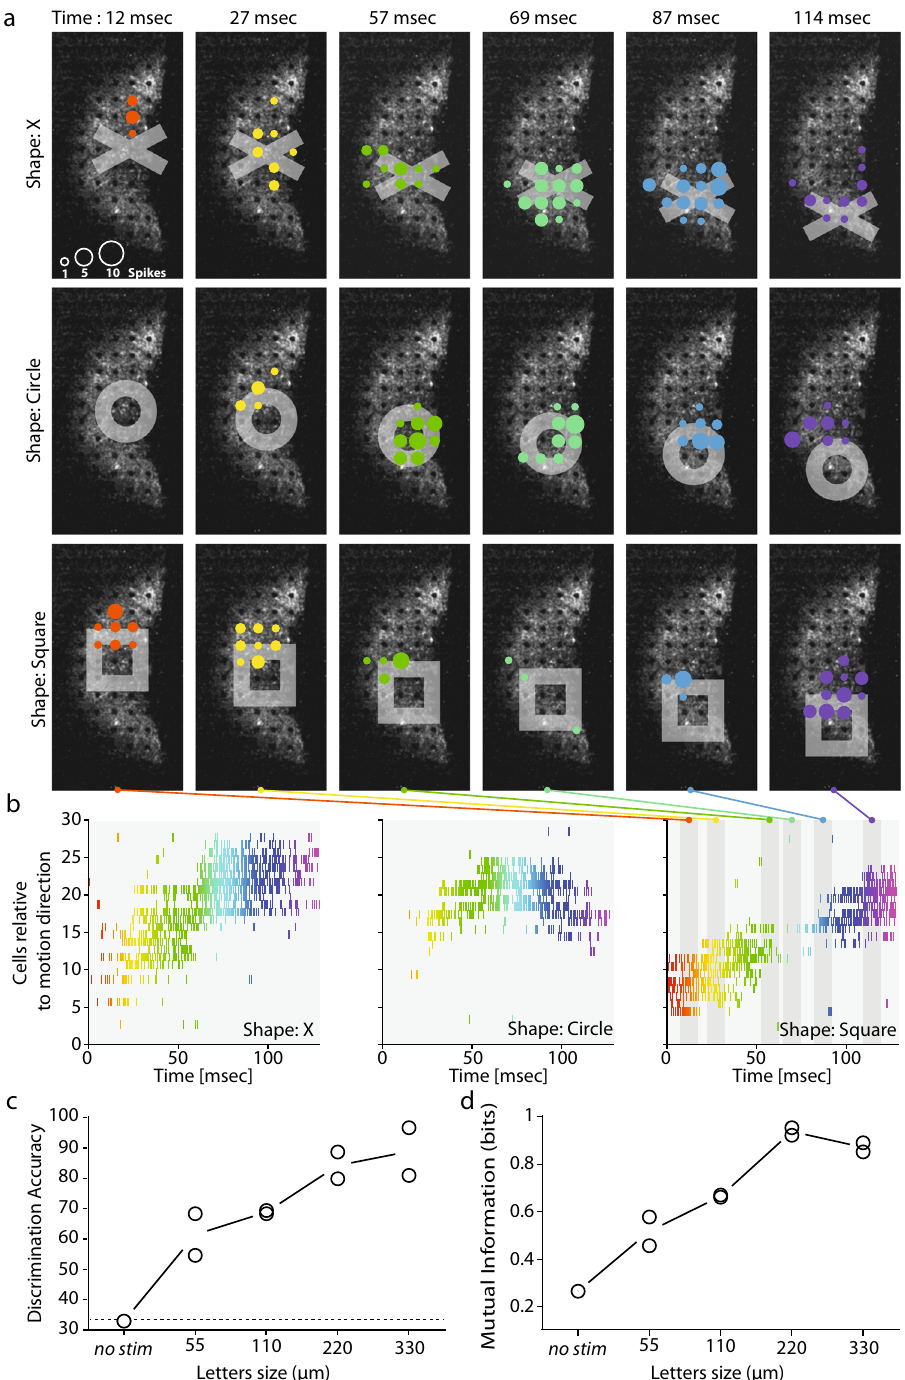
Fig. 7 The measured activity can be used to discriminate stimulation with different shapes and to predict visual acuity. a Responses of cells to three different shapes (rows: X, circle and square, columns: six different times) moving from the center towards the bottom of the retina. The colored disks indicate the electrodes where cells are recorded spiking. The size of the disks show the number of spikes detected in a 10-ms time window centered on the time indicated at the fi gure top. Color of the disks changes with timing in the sequence. b Raster plots showing the activity of the cells over time. The three shapes (X: left, circle: center and square: right) triggered different patterns of activity in the cell population. Color of the action potential on the raster change with time, fi tting the color code in a . The six different time windows used in a are shown as the gray area over the right panel (square). c Discriminability (as a %) of the features of the spatiotemporal spike response obtained from population spike trains for different sizes. Discriminability increased with letter size. “ No-stim ” discrimination was performed with the spontaneous activity pattern just before the start of stimulation. The no-stim discrimination rate was about 33%, as would be expected by chance alone for three shapes. d Normalized mutual information from the confusion matrix obtained from the discrimination rates in ( c ). The information tends to increase with the size of the shapes, with saturation occurring at 220 µ m. The information and discriminability at 220 µ m indicate a visual acuity above the de fi ned threshold for legal